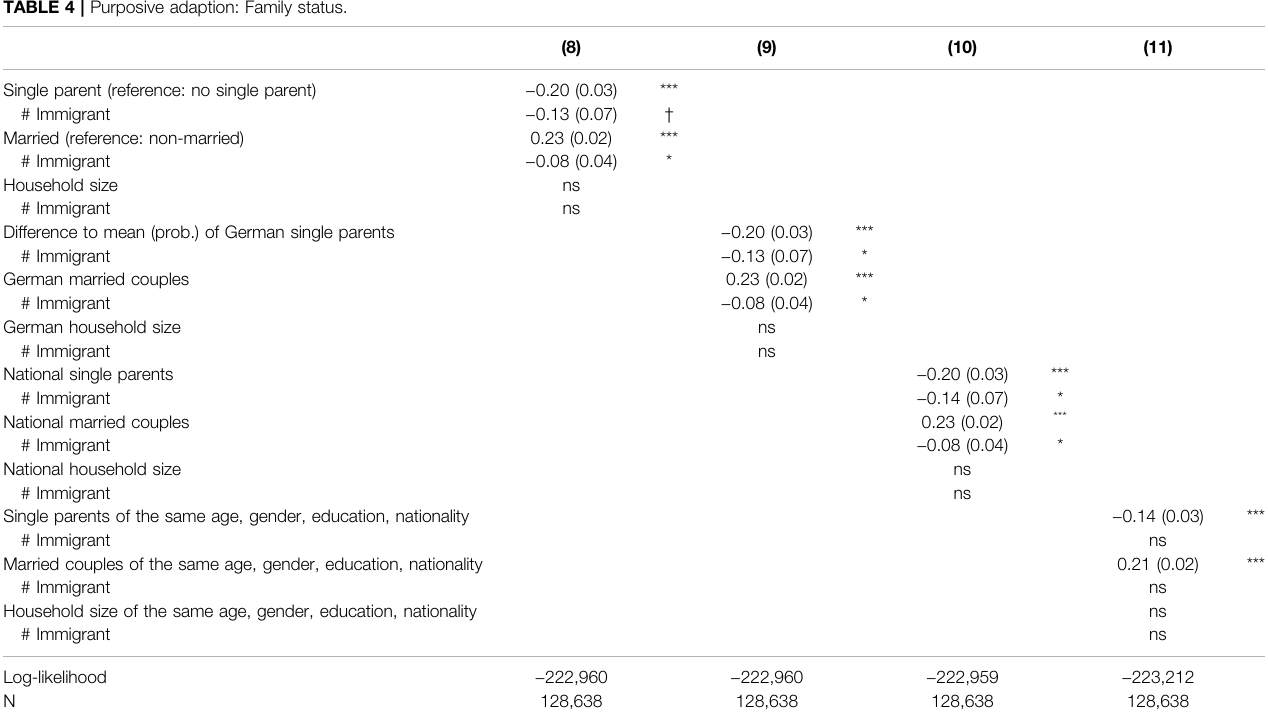
TABLE 4 | Purposive adaption: Family